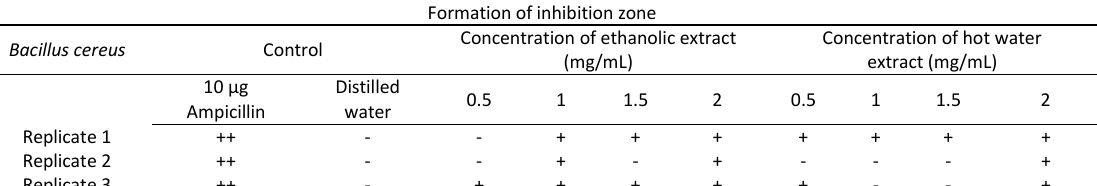
Table 4: Inhibition zone of B. cereus